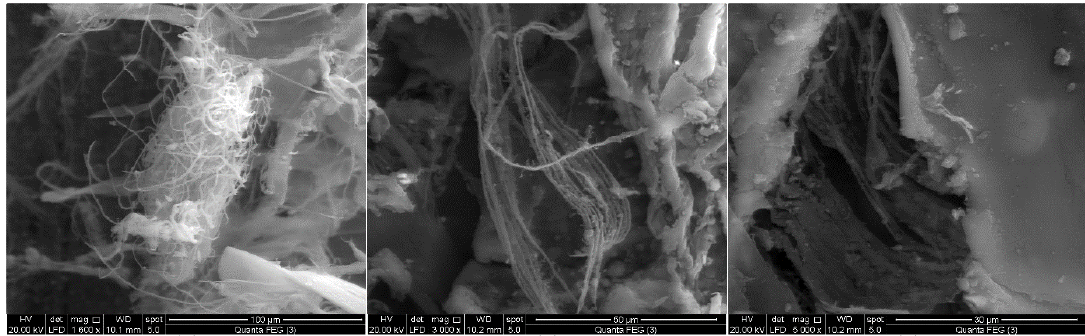
Figure 4. SEM of the one-step extracted P. americana chitin (OSPC) flakes at different magnification powers revealing the nanofibers composing the surface of the flake.